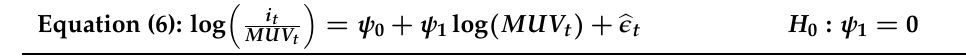
Table 2. Multiresolution decomposition of logarithm of the real Grilli and Yang commodity price index. The reported values are the least squares estimates of the slope coefficient in Equation (6). The p -values are reported in brackets underneath the